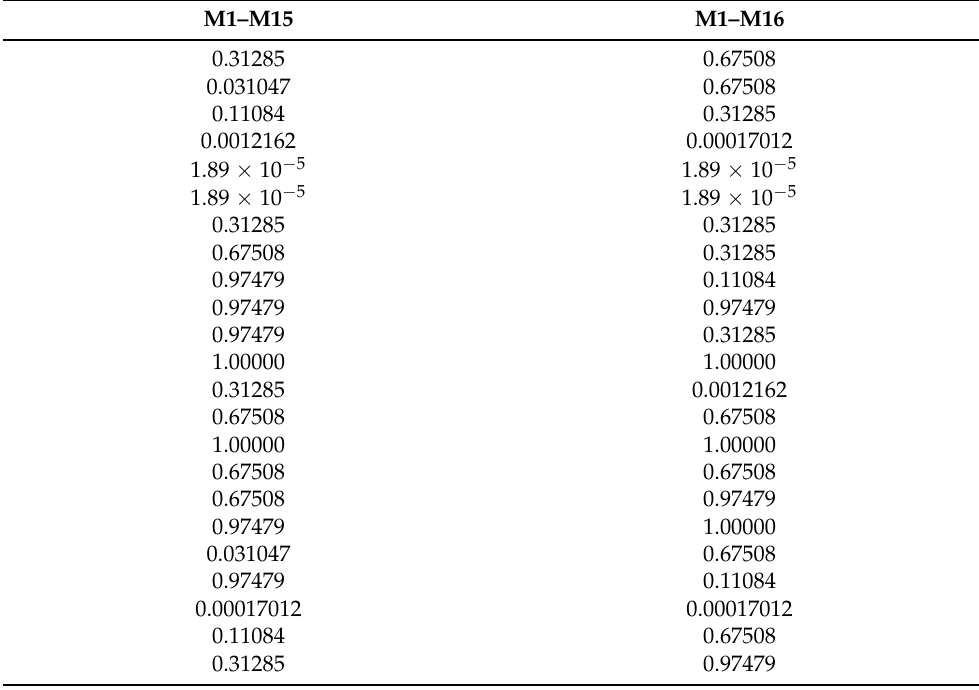
Table A4. p -values of the Kolmogorov–Smirnov test Models 15 and